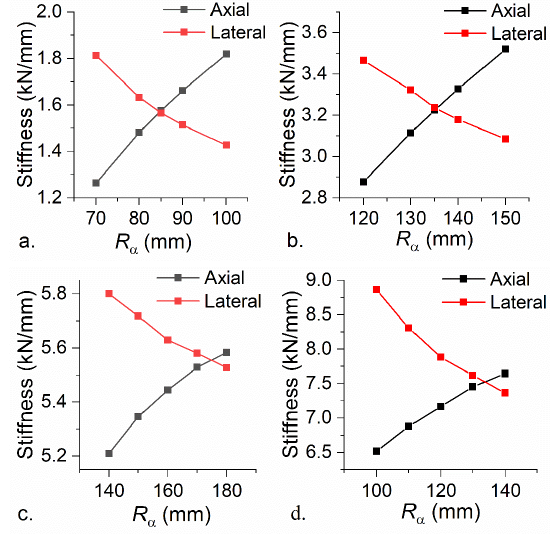
Figure 14: a) Calculated stiffness vs meridional radius of DN50; b) calculated stiffness vs meridional radius of DN100; c) calculated stiffness vs meridional radius of DN125; d) calculated stiffness vs meridional radius of